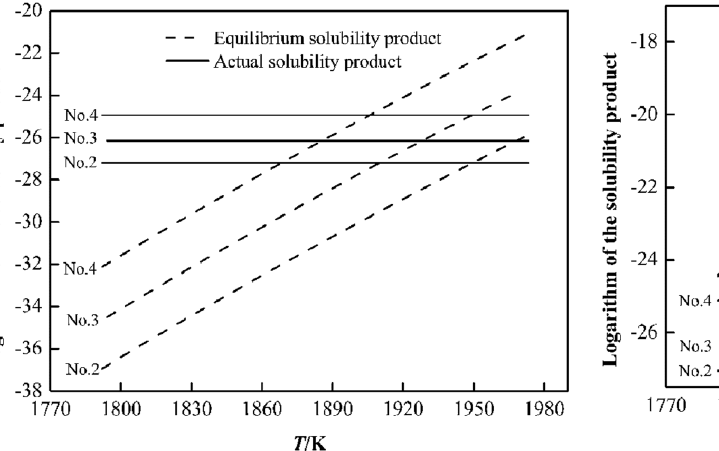
Figure 4: Logarithm of the solubility product as a function of temperature for Y 2 O 3 in the liquid steel.